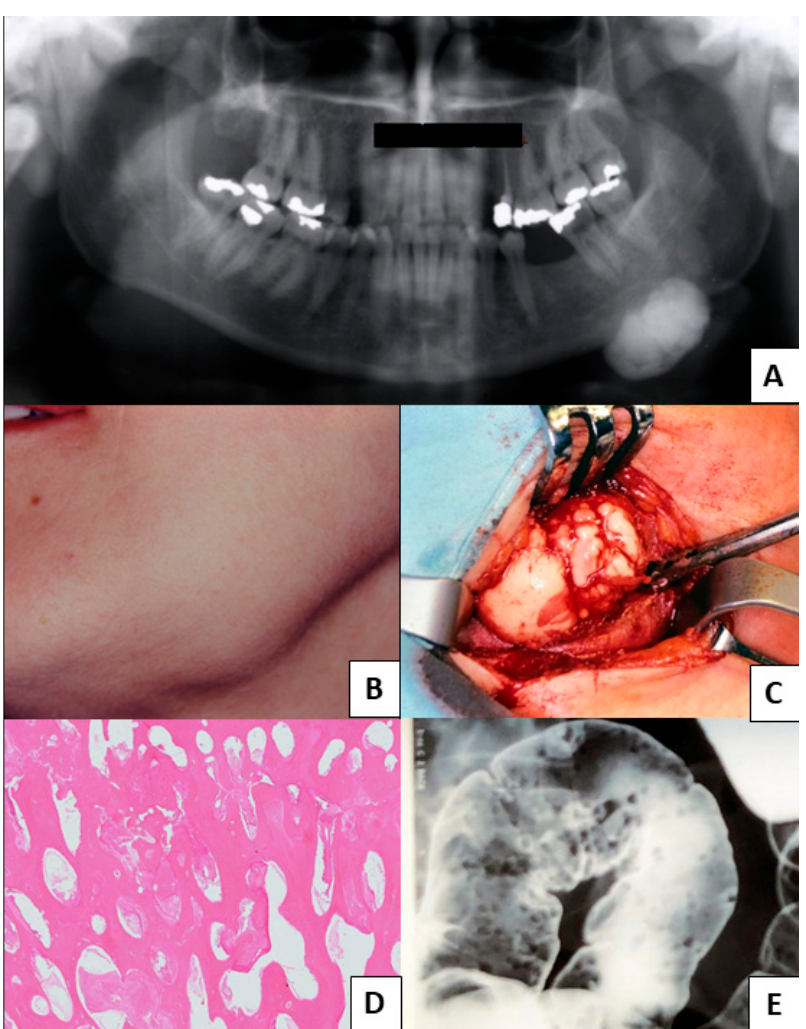
Figure 3. Clinical Case 1. ( A – D ) Spongious osteoma of the lower margin of the mandible (panoramic radiogram, facial dysmorphism, intraoperative images, and histological hematoxylin – eosin, respectively); ( E ) the double-contrast barium enema shows the multiple polypoid lesions found in the same patient’s colon.